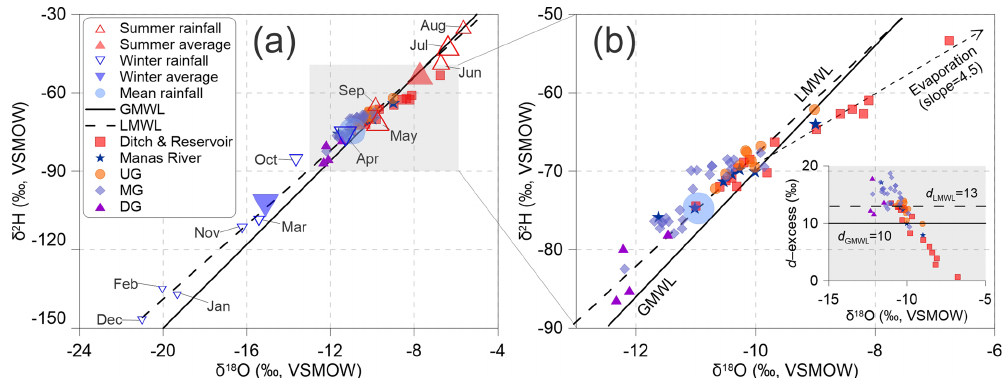
Figure 5. (a) Plot of stable isotopes of surface water and groundwater from the mountain to the oasis plain compared to the global meteoric water line (GMWL; Craig, 1961) and the local meteoric water line (LMWL, rainfall in Urumqi station of IAEA networks during 1986 and 2003; data are available at https://www.iaea.org, last access: 27 January 2016). The size of the hollow triangles stands for the relative amount of precipitation. “Mean rainfall” refers to the annual amount-weighted mean rainfall isotopic value. (b) Plot of δ 2 H vs. δ 18 O and inserted plot d excess vs. δ 18 O. UG: upstream groundwater, MG: midstream groundwater, DG: downstream groundwater.